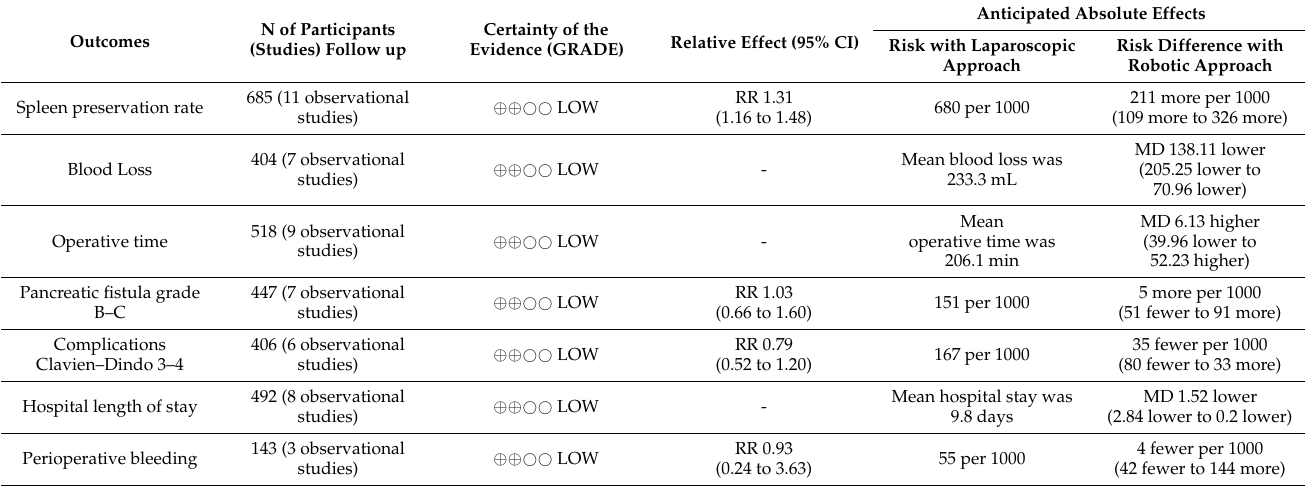
Table 4. Robotic versus laparoscopic surgery for spleen-preserving distal pancreatectomies. * The risk in the intervention group (and its 95% confidence interval) is based on the assumed risk in the comparison group and the relative effect of the intervention (and its 95% CI). CI: Confidence interval; RR: Risk ratio; MD: Mean